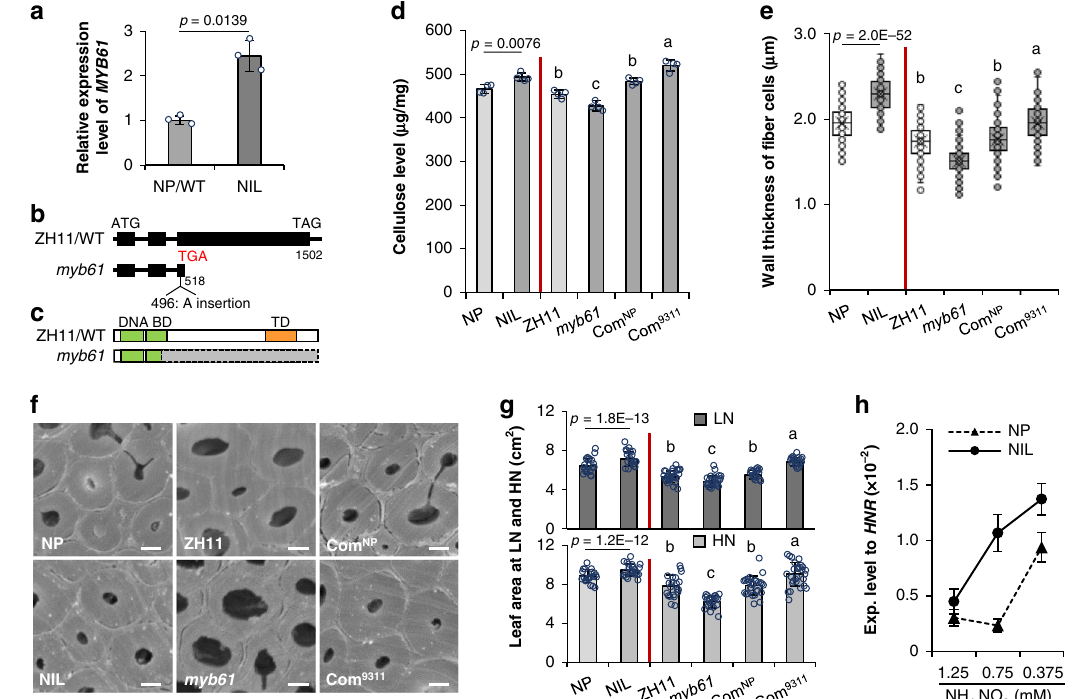
Fig. 3 Validation of the MYB61 function. a qPCR analysis of MYB61 in NP/WT and the NIL containing the 9311- MYB61 fragment, showing the relative expression to rice HNR . Transcription level in NP was set as 1. Error bars represent the mean ± SD of three biological replicates. b Schema of MYB61 gene structure and the mutation site in myb61 . Boxes and lines in the diagram indicate exons and introns, respectively. c Schema of MYB61 protein. Green boxes indicate DNA binding domain (BD) and orange box indicates the transactivation domain (TD). Gray box indicates the truncated part in the mutant. d The cellulose content, µ g in per mg of cell wall residues prepared from the internodes of the indicated plants. Error bars indicate the mean ± SD of four biological replicates. e Boxplot of the wall thickness of sclerenchyma fi ber cells in the indicated plants. Box bounds represent the 25th and 75th percentile, center line represents the median, × indicates the mean, and whiskers represent the 25th percentile − 1.5 * the interquartile range and the 75th percentile + 1.5 * the interquartile range. n = 200 cells from three individual internodes of the indicated plants. f SEM graphs of sclerenchyma fi ber cells from the internodes of the indicated plants. Bars = 2 μ m. n = 3 biologically independent plants. g The leaf area of the indicated seedlings growing in the media with LN (0.2mM NH 4 NO 3 ) and HN (5mM NH 4 NO 3 ) supply. Error bars indicate the mean ± SD of at least 19 seedlings. h The expression level of MYB61 in the leaf sheaths of NP and the NIL seedlings treated in varied concentrations of NH 4 NO 3 for 2h. Rice HNR was used for normalization. Error bars represent the mean ± SD of four biological replicates. Statistical signi fi cance was calculated with two-tailed Welch ’ s unpaired t -test and p values are indicated in ( a , d , e , g ). Letters a – c in ( d , e , g ) indicate the different means according to Duncan ’ s multiple range test ( p <0.05). Com NP and Com 9311 represent the plants expressing the complementary constructs shown in Supplementary Fig. 2e. The red vertical lines in ( d , e , g ) were used to separate the plants with different genetic background. NP, Nipponbare; NIL, near- isogenic line; ZH11, Zhonghua11. Source data underlying Fig. 3a, d, e, g, h are provided as a Source Data fi